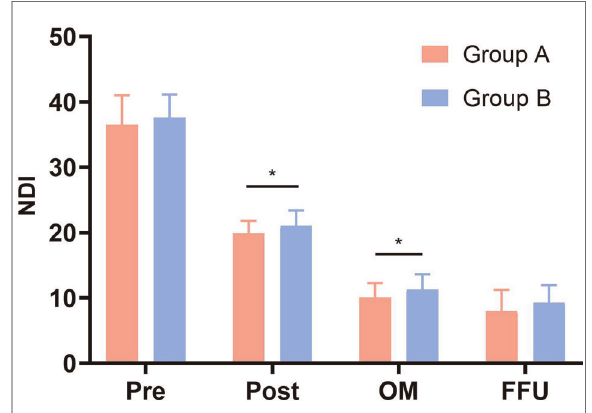
FIGURE 2 Comparison of NDI scores between two groups. Pre, preoperative; Post, postoperative; OM, one month after surgery; FFU, fi nal follow-up. *Signi fi cance between the two groups, P <.05.